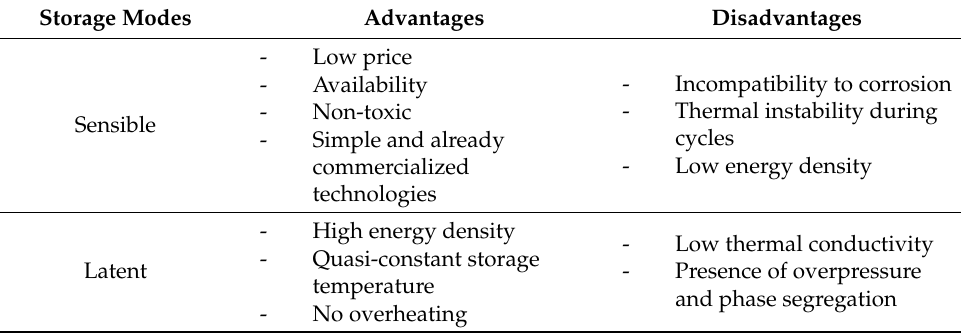
Table 1. Advantages and disadvantages of the different storage modes